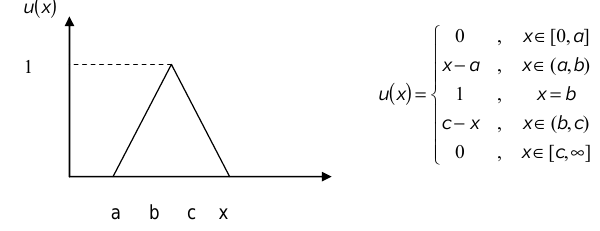
Figure 1: Triangular fuzzy number and the membership function figure